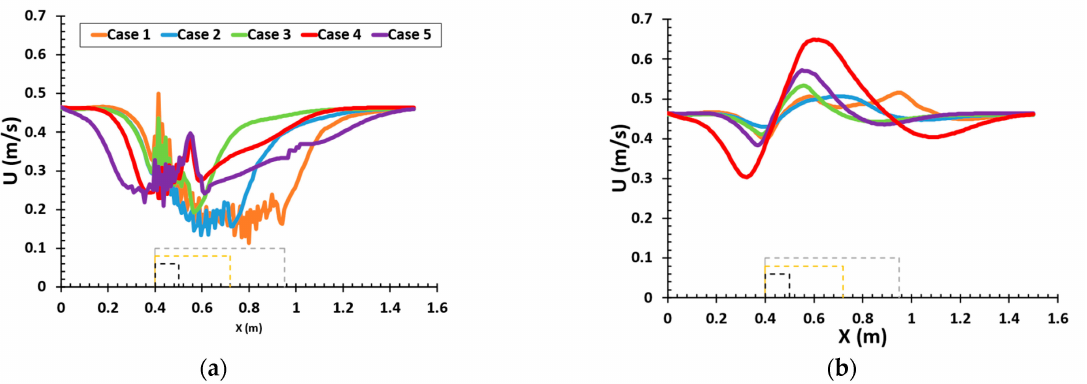
Figure 10. Longitudinal distributions of streamwise velocities, ( a ) along the longitudinal section LS1 and ( b ) along the longitudinal section LS2. The dashed lines show the Vegetation length area ( W x